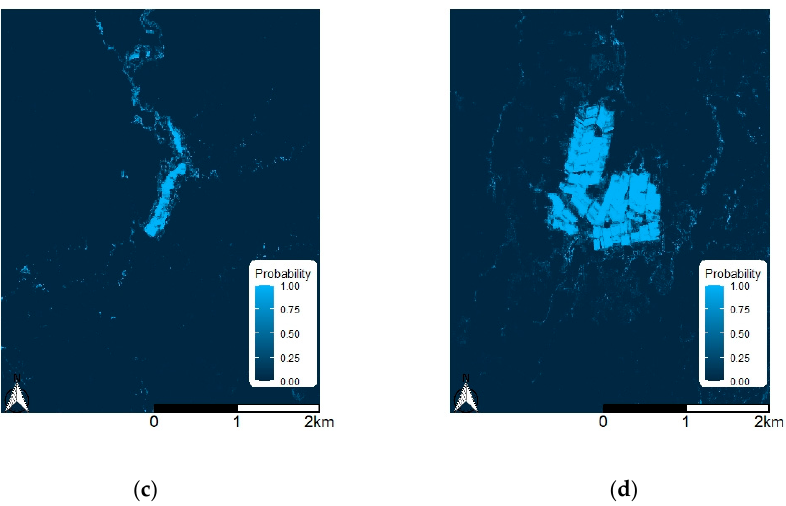
Figure 3. Probability of pixels being classified as irrigated, defined as the proportion of 500 decision trees in the random forest model, for annual datasets over ( a ) Ord River Irrigation Area, ( b ) Silalatshani, ( c ) Nabusenga, and ( d ) Lungwalala. ( b ) Silalatshani, ( c ) Nabusenga, and ( d ) Lungwalala.